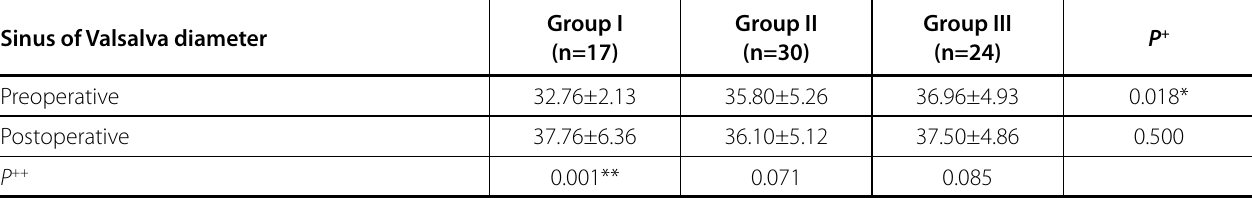
Table 5 . Changes in sinus of Valsalva diameters in different groups. Sinus of Valsalva